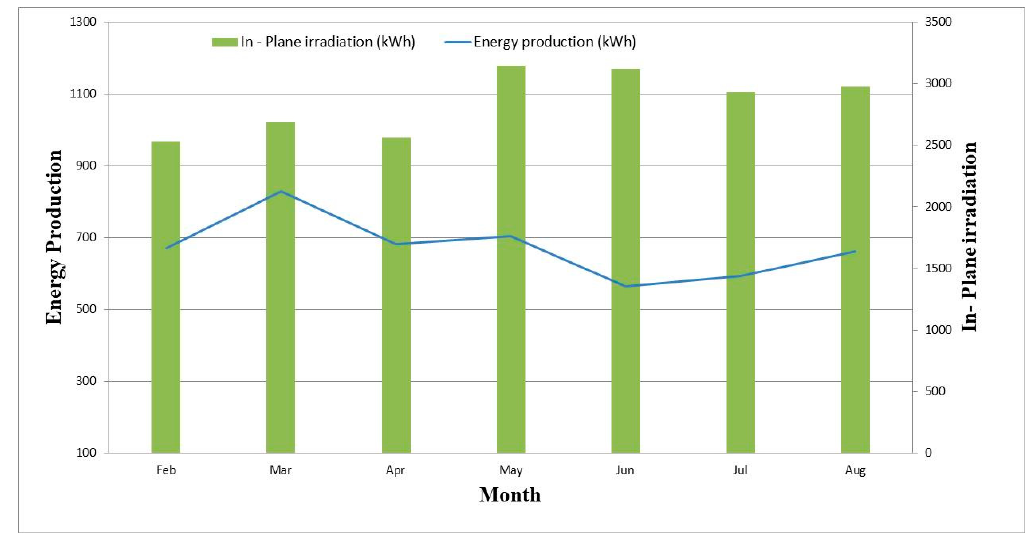
Figure 5. Monthly energy production and in-plane irradiation.